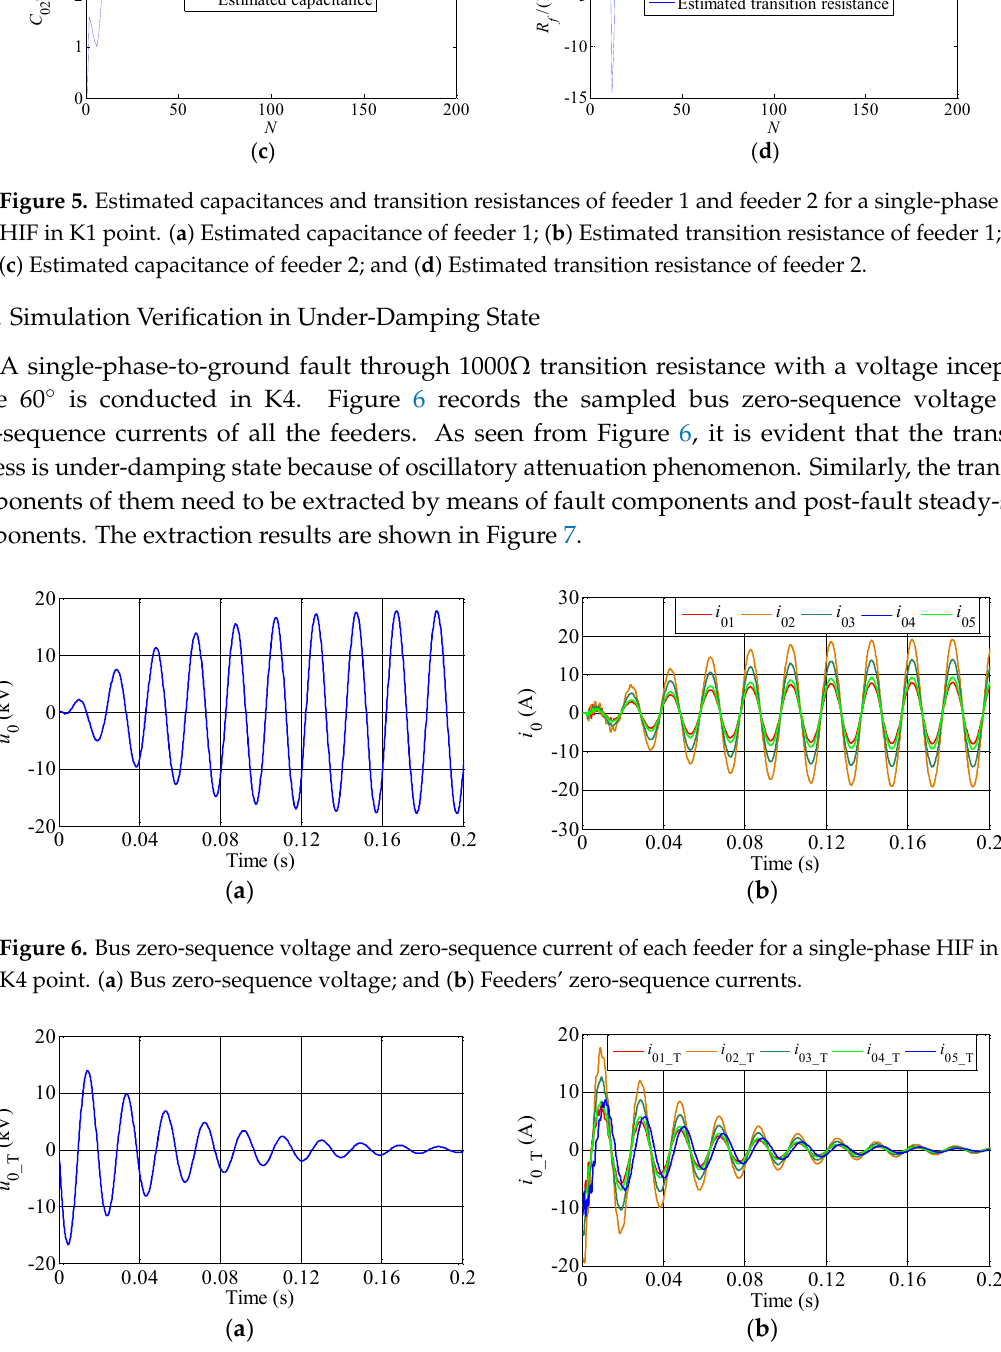
Figure 7. Transient components of bus zero-sequence voltage and feeders’ zero-sequence currents for a single-phase HIF in K4 point. ( a ) Transient component of bus zero-sequence voltage; ( b ) Transient components of feeders’ zero-sequence currents.